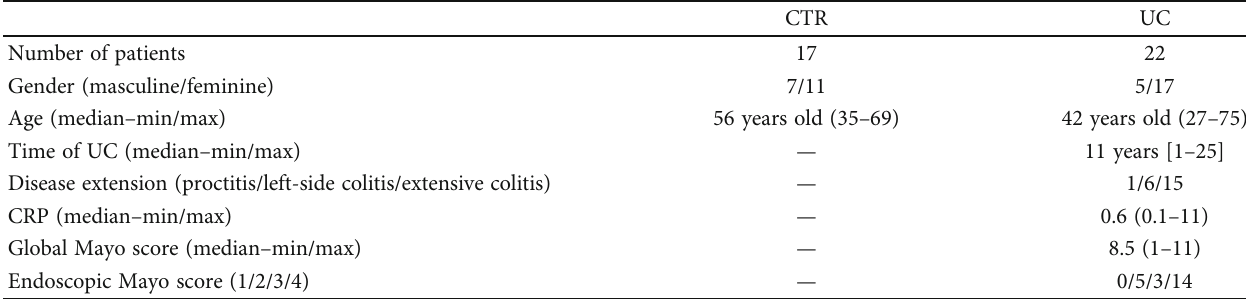
Table 1: Demographic and clinical data from all patients included in the